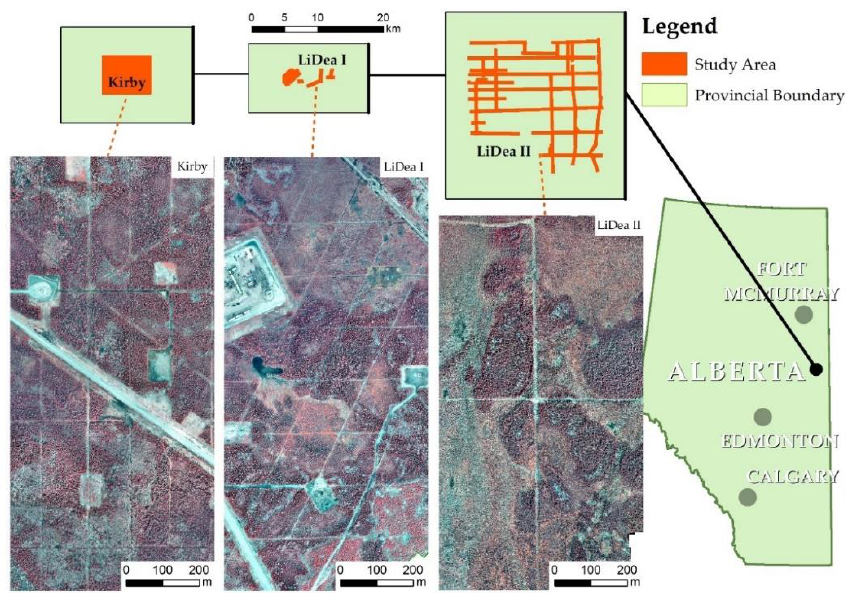
Figure 4. Display of the study sites Kirby, LiDEA I and LiDEA II in northeastern Alberta. Each area is presented with an inset at a larger scale showing a false color aerial photo of example linear disturbances. Airborne imagery is the property of the Boreal Ecosystem Recovery and Assessment (BERA) project.